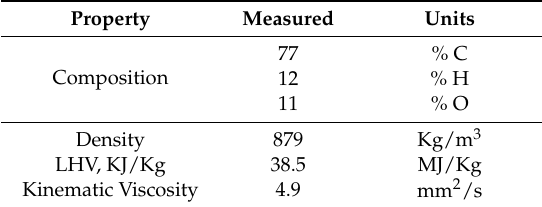
Table 6. Properties of biodiesel